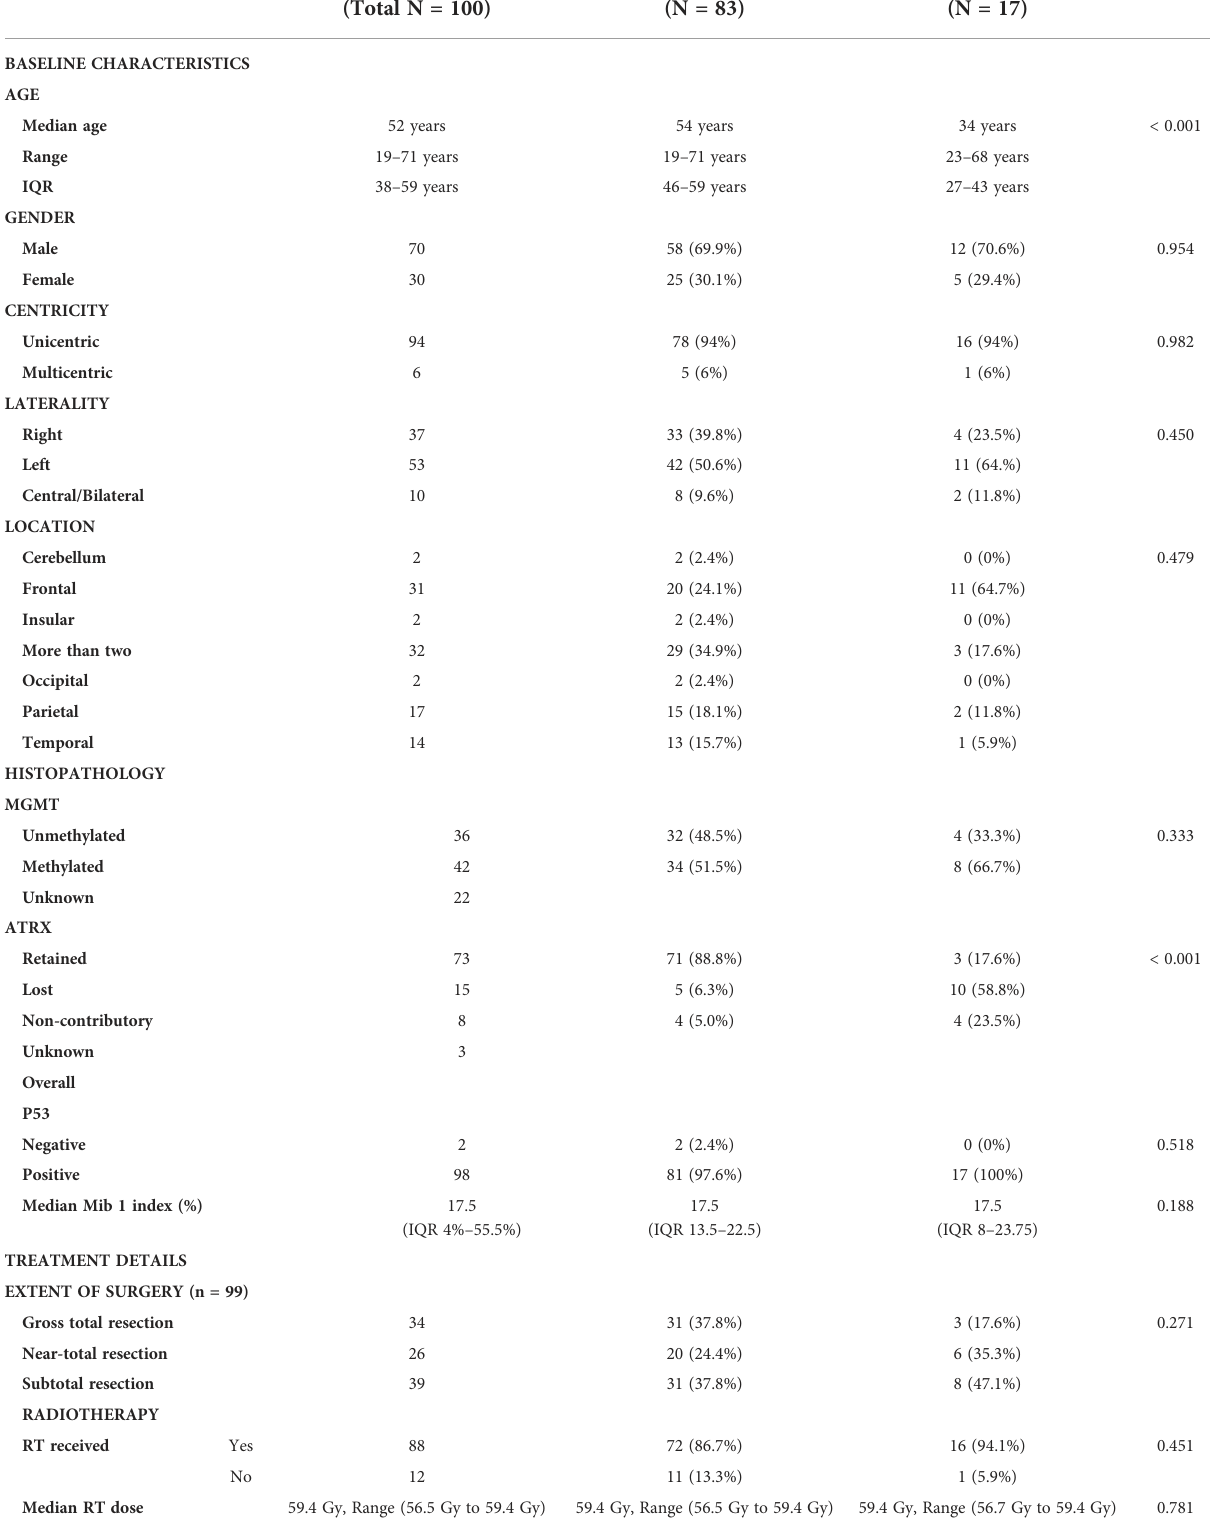
TABLE 2 Demographic, tumor and treatment pro fi le of grade 4 IDH mutant astrocytoma and IDH wild type